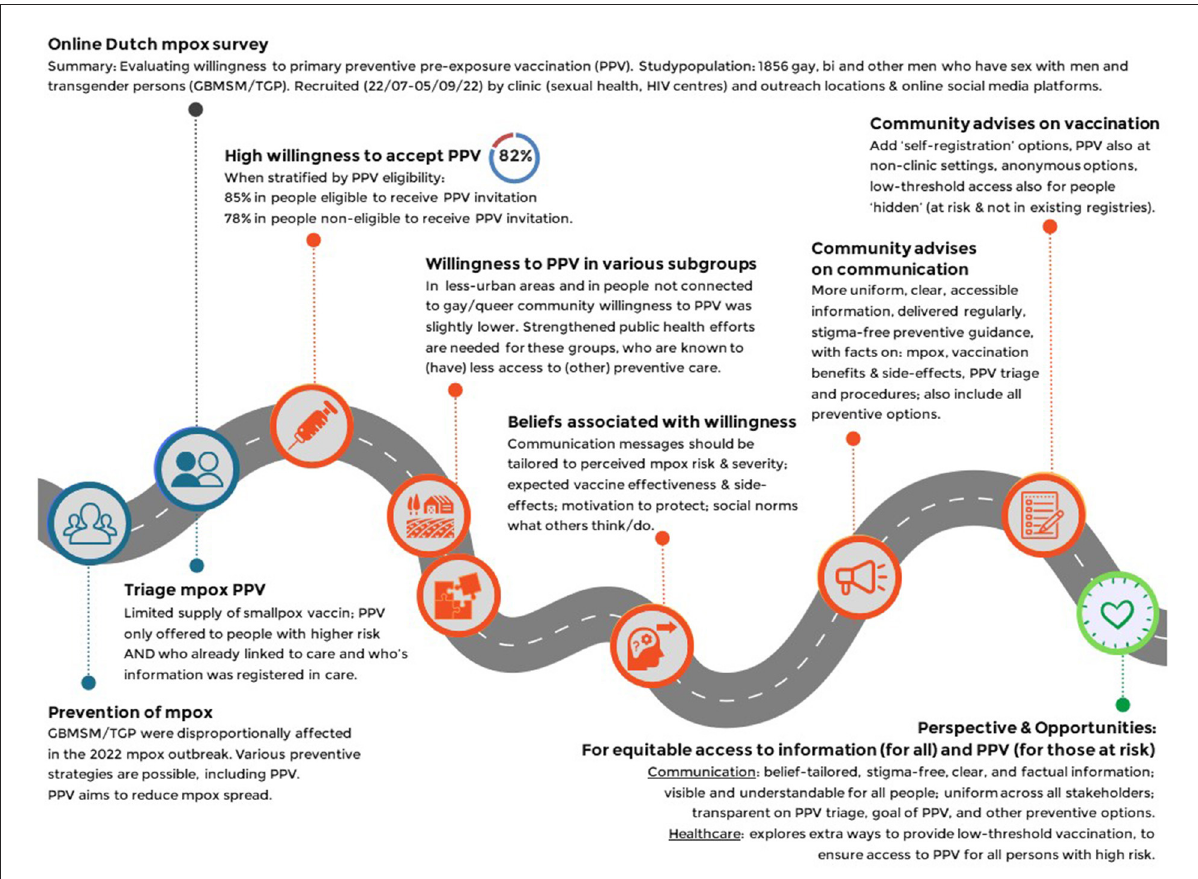
FIGURE4 Visual summary of the study findings and conclusion. Dutch online mpox-survey (22 July-5 Sept